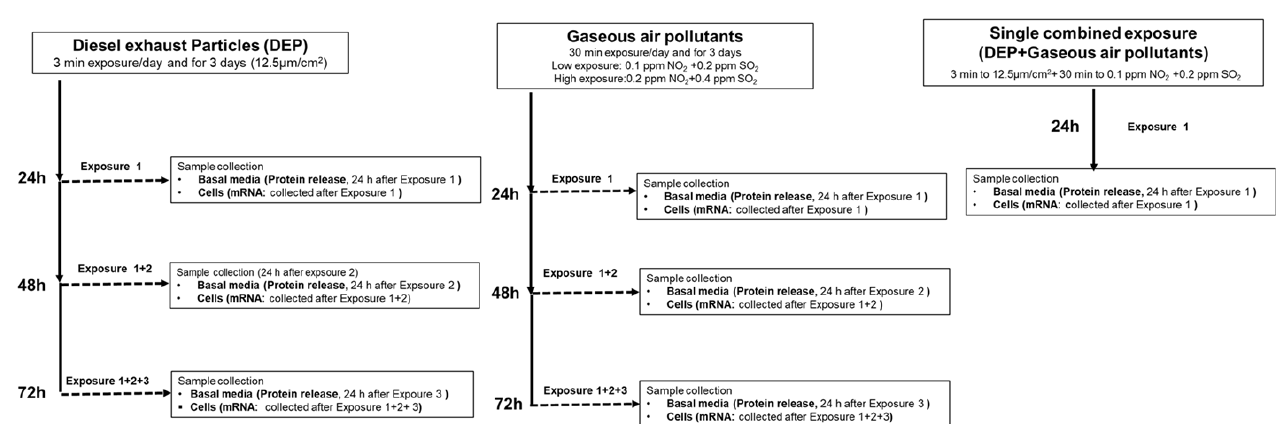
Figure 1. Schematic presentation of the overall experimental design. Basal medium was collected and replaced with fresh air – liquid interface medium 24 hour (h) after each exposure, before the following exposure was carried out.